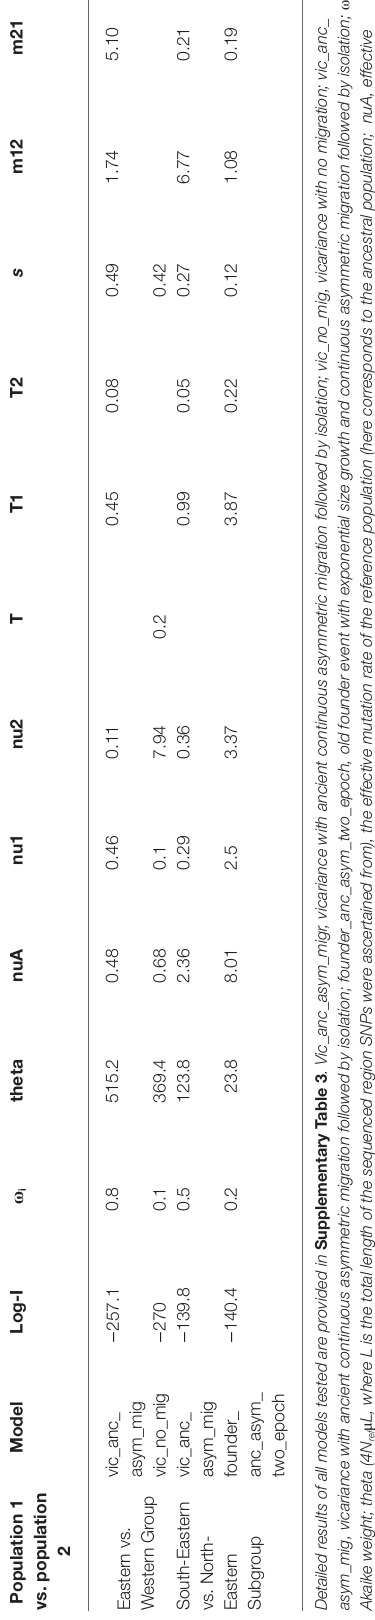
( Figure 2 ; Supplementary Figure 1 ), suggests that H. niger has survived the LGM not only in the major beech forest refugium in the northwestern Balkan Peninsula (Magri et al., 2006), which reflects the species’ relatively lose connection to beech forests. Instead, survival in three disjoint refugia is supported by both genetic/ genomic data and the species’ modeled distribution at the LGM ( Figure 1C ); two of these refugia were situated along the unglaciated margin of the Southern Limestone Alps and one, unexpectedly, was located in the eastern part of the Northern Limestone